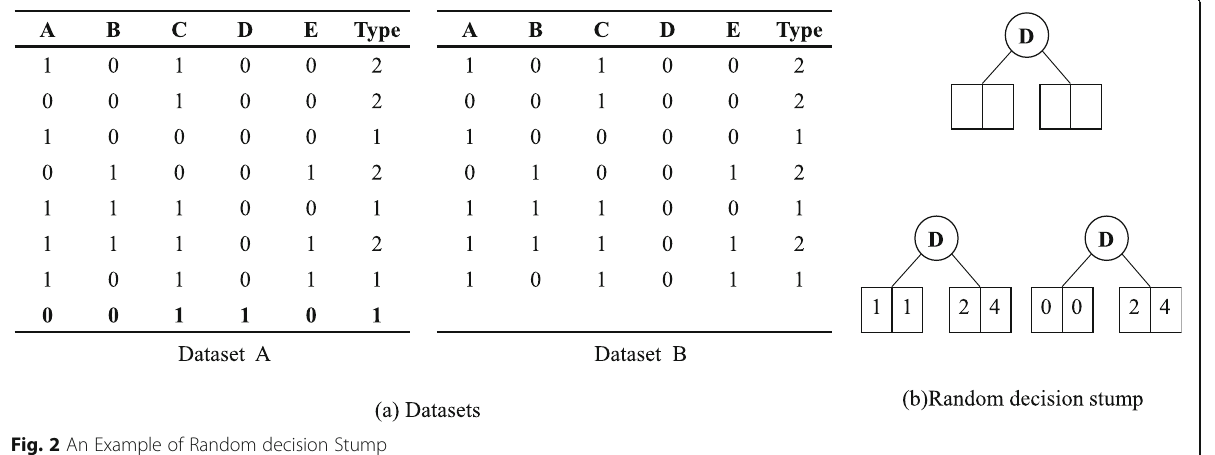
Fig. 2 An Example of Random decision